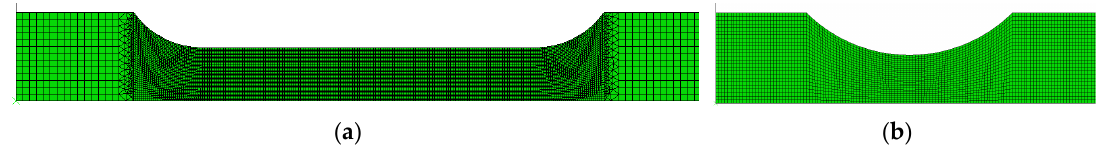
Figure 16. The finite element models for 2024-T351 aluminum alloy tension specimens. ( a ) Smooth round bar; and ( b ) R12 notched round bar.